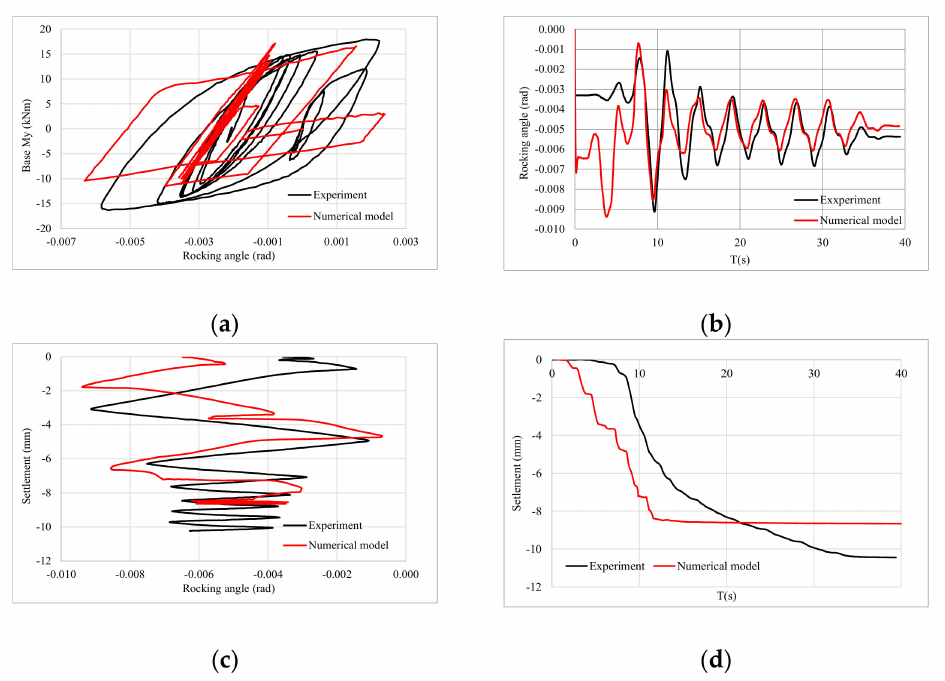
Figure 5. Comparison of numerically and experimentally obtained data: ( a ) rocking angle- overturning moment; ( b ) time-rocking angle; ( c ) rocking angle-settlement; ( d ) time-settlement.